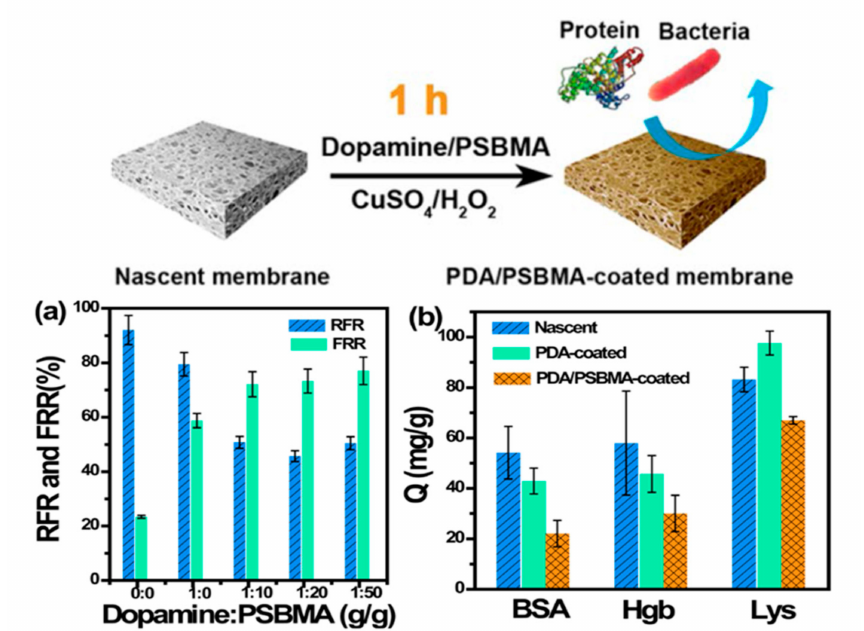
Figure 21. ( Top-line ) Co-deposition of PDA/PSBMA Triggered by CuSO 4 /H 2 O 2 ; ( Bottom-line ) ( a ) Dynamic BSA filtration and ( b ) protein (BSA, Hgb, and Lys) adsorption quantity of the nascent and PDA/PSBMA-coated PPMMs. Reproduced with permission from Reference